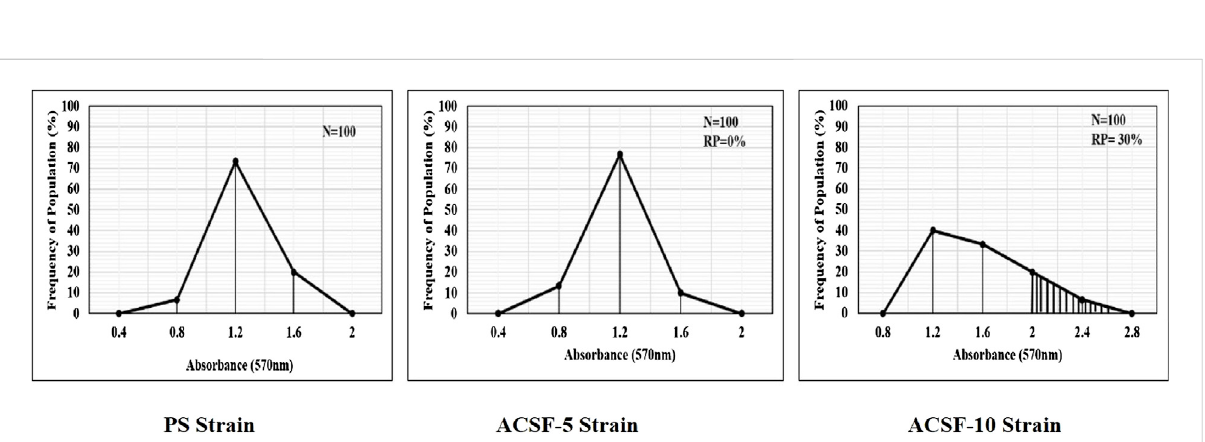
FIGURE 2 Frequencydistributionsofabsorbancevalue(570nm)asthe α -esterasesactivity(nmol/min/mgofprotein)inthelarvaeofPS(parentsusceptible strain), ACSF-5 (acetamiprid larval-selected fi lial-5), and ACSF-10 (acetamiprid larval-selected fi lial-10) strains of Aedes aegypti ( n = 100). The susceptibility threshold is based on the maximum absorbance in the PS strain. The shaded region represents the resistant population (above the threshold). n = number of larvae; RP = resistant